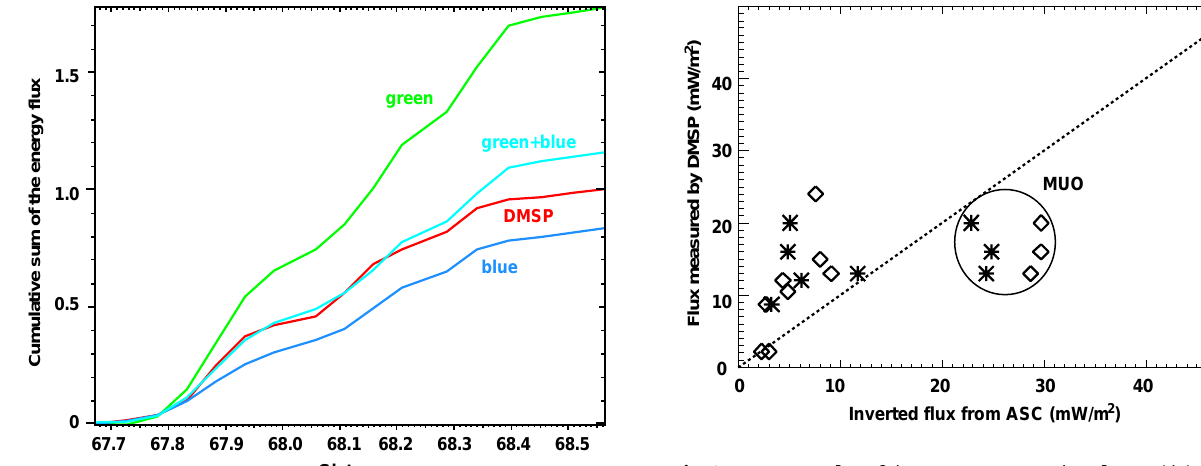
Fig. 6. A scatter plot of the energy flux peak values within auroral arc systems of the four satellite conjugate events. The energy fluxes of the modified inversion method from blue (asterisks) and green (diamonds) line images are compared to the satellite measurements. Inversion results of the best event over Muonio (31 January 2001) are marked by MUO. The other events took place close to the hori- zon of ASCs in Abisko and